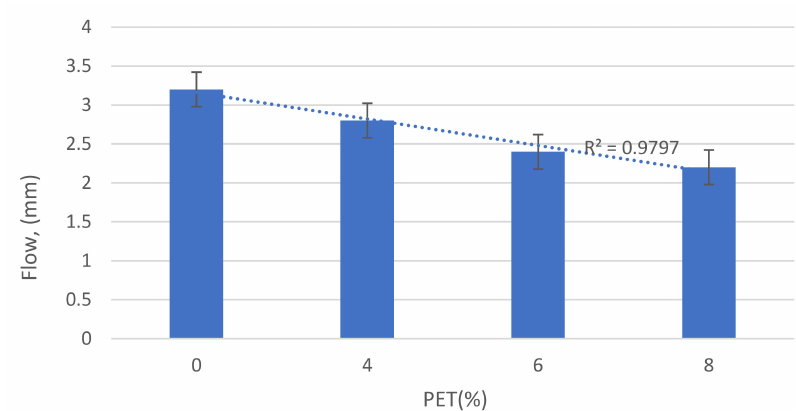
Figure 6. Marshall stability results.